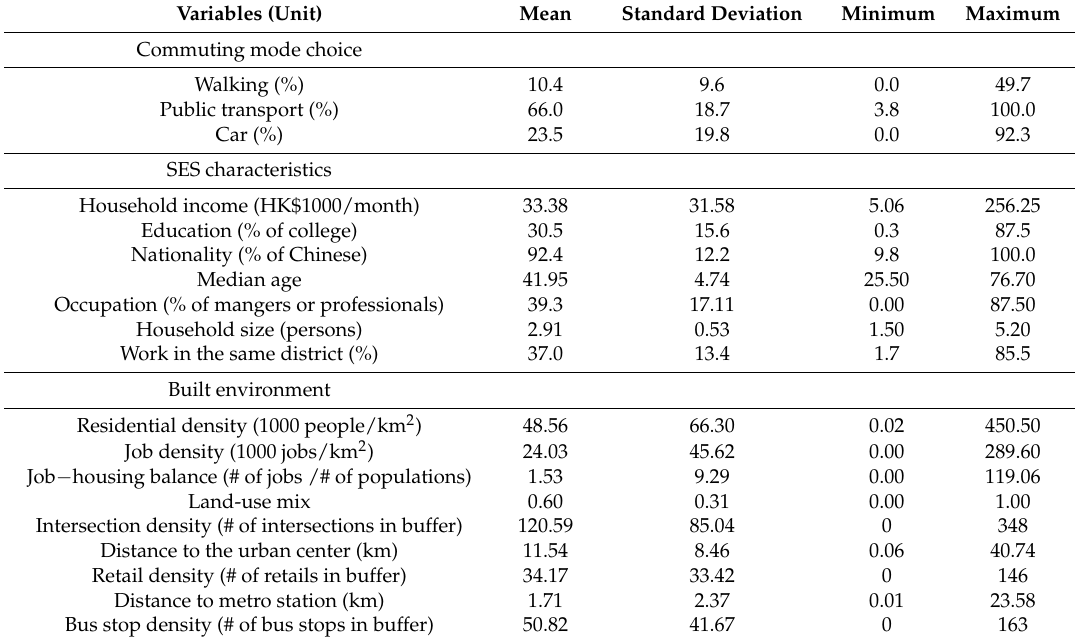
Table 2. Descriptive statistics of commuting mode choice, socioeconomic, and built environment characteristics in a street block, using 2011 Hong Kong Census